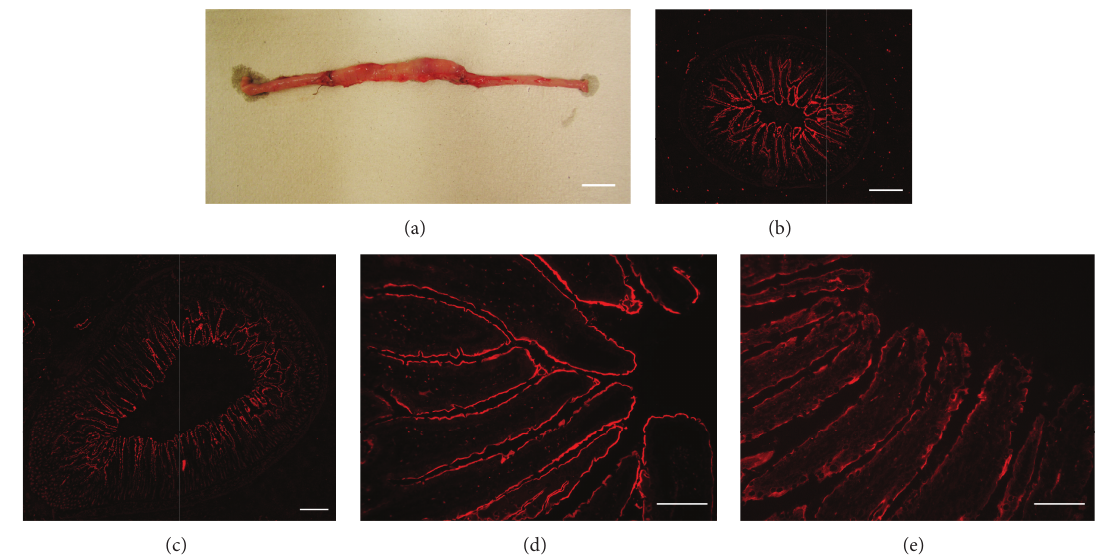
Figure 7: Macroscopy appearance of interposed ileum (a) and immunohistochemistry of the interposed ileum ((c), (e)) in comparison with the respective ileal segment of a sham-operated animal ((b), (d)). The samples were taken after the animals had been killed in the 3rd week after sham or IIP surgery. Immunostaining in (b)–(e) was performed with SGLT1-Ab. Representative images are shown. Bars: (a) 2 cm, (b) and (c) 500 𝜇 m, and (d) and (e) 50 𝜇